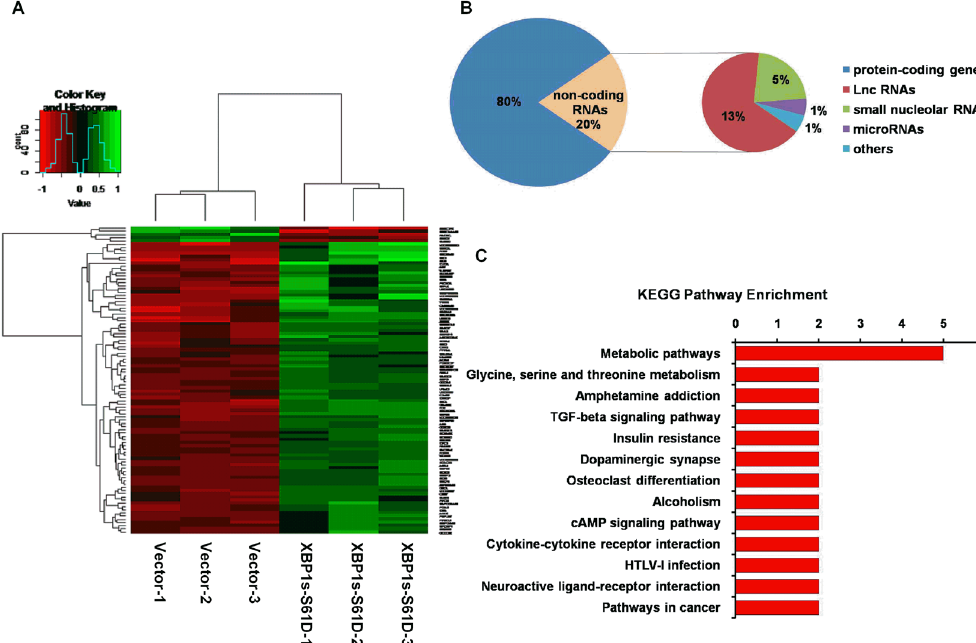
Figure 5. Phosphorylated XBP1s acts as a transcription factor to induce the expression of multiple genes. ( A ) Unsupervised hierarchical clustering analysis of the differentially expressed genes between overexpressing vectors and XBP1s-S61D plasmid cell groups (based on fold change ≥ 2, P < 0.01). The rows represent different genes, and the columns represent overexpressing vectors and XBP1s-S61D samples. The color scale on the top shows the relative expression level of mRNAs: green represents upregulation and red represents downregulation. ( B ) The ratio of protein-coding RNAs and ncRNAs in differentially expressed genes (fold change ≥ 2, P < 0.01) is presented, and the proportion of different ncRNAs is shown in the smaller pie chart. ( C ) Kyoto Encyclopedia of Genes and Genomes (KEGG) pathway analysis of the differentially expressed genes. The x-axis indicates the counts of genes and the y-axis indicates the